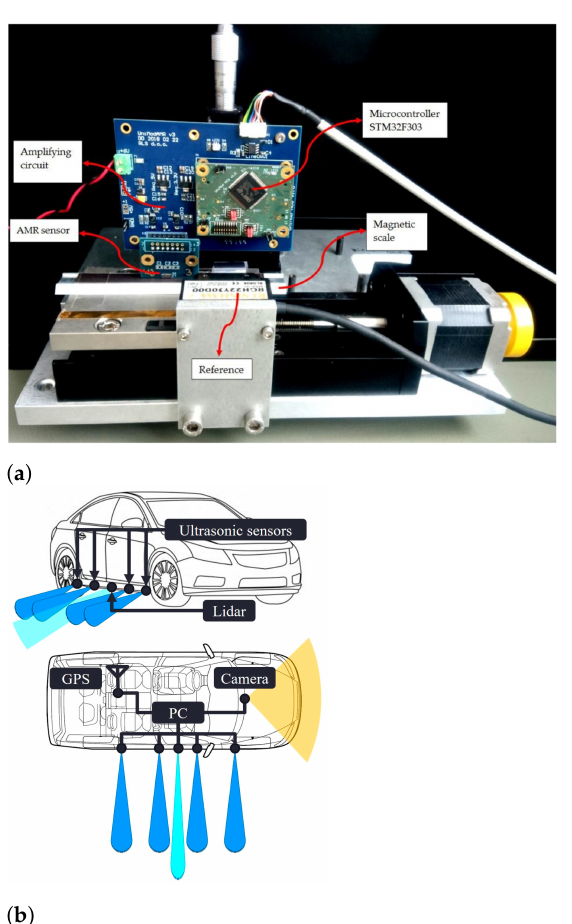
Figure 5. Usage of homogeneous sensor systems: ( a ) A system using array of magnetoresistive sensors [18]. ( b ) A system using array of ultrasonic sensors